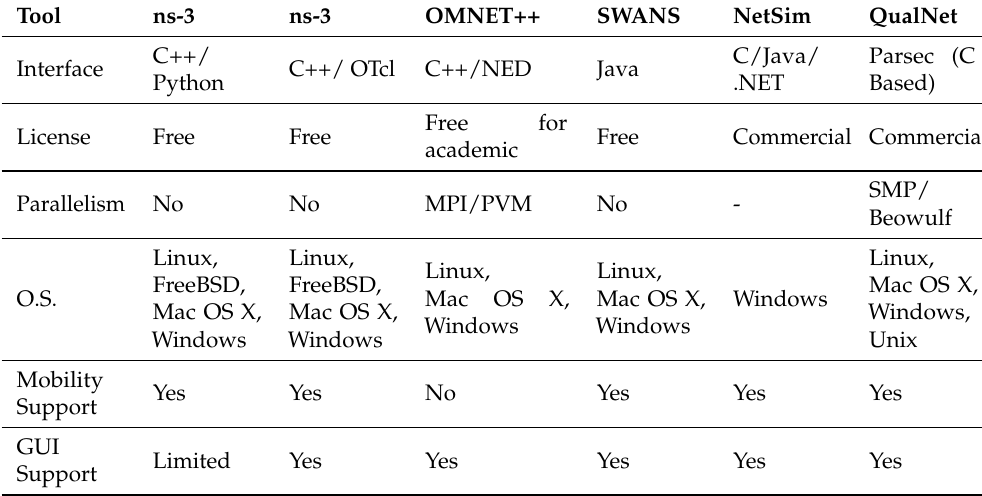
Table 1. Comparison of network